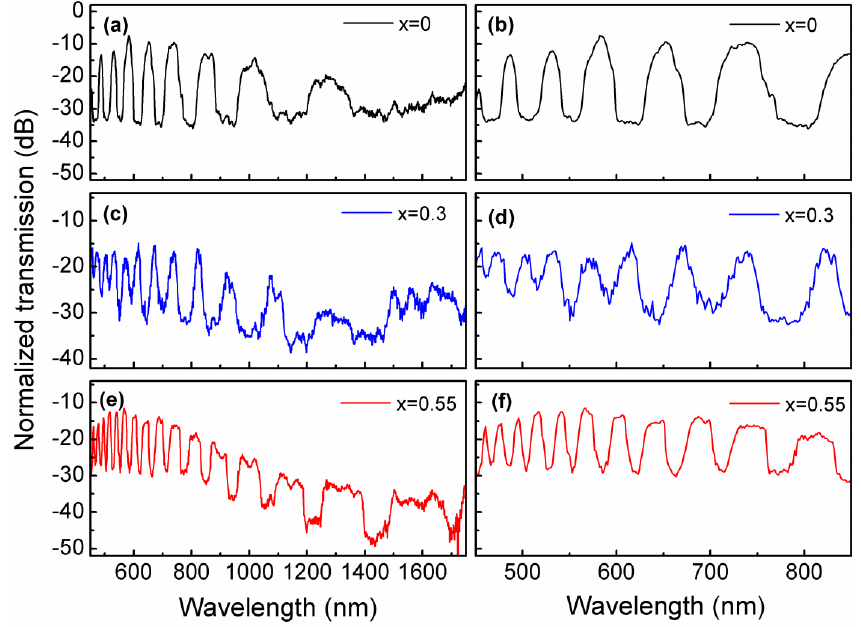
Figure 3. Transmission spectra of 1 cm long x AgI + (1− x )AgPO x = 0, 0.3 and 0.55, prepared following fast-cooling method. Insets on the right